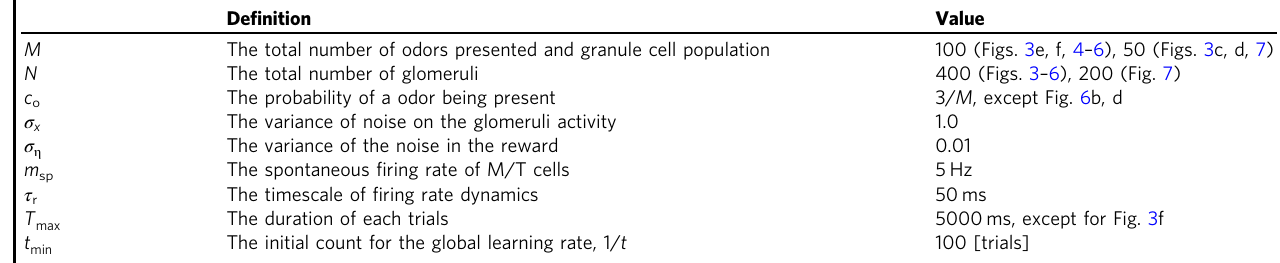
Table 1 De fi nitions and values of the